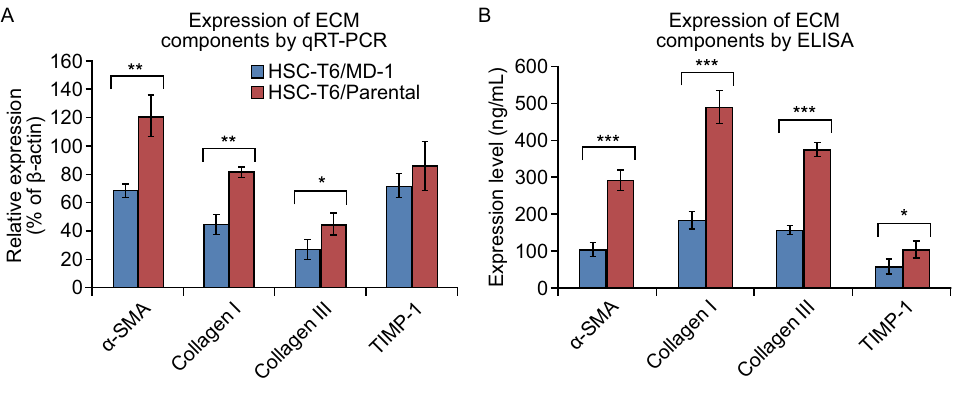
Figure 5. Inhibitory effects of MD-1 on ECM synthesis and secretion in HSC-T6 cells. (A) Relative expression levels of ECM components, including α -SMA, collagen I and III, and TIMP-1, as detected by real-time quantitative PCR (qRT-PCR). * P < 0.05; ** P < 0.01. (B) Expression of ECM components in the collected cell supernatant as determined by ELISA. * P < 0.05; *** P <